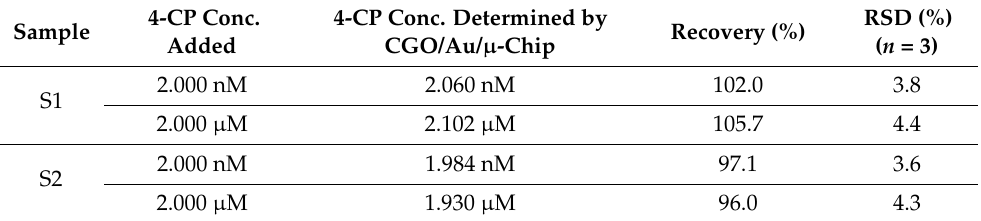
Table 1. Investigation of environmental samples by the CGO/PEDOT:PSS/Au/ µ -Chip assembly.